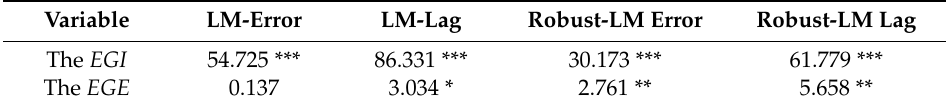
Table 2. Test results of LM for the EGE and EGI .